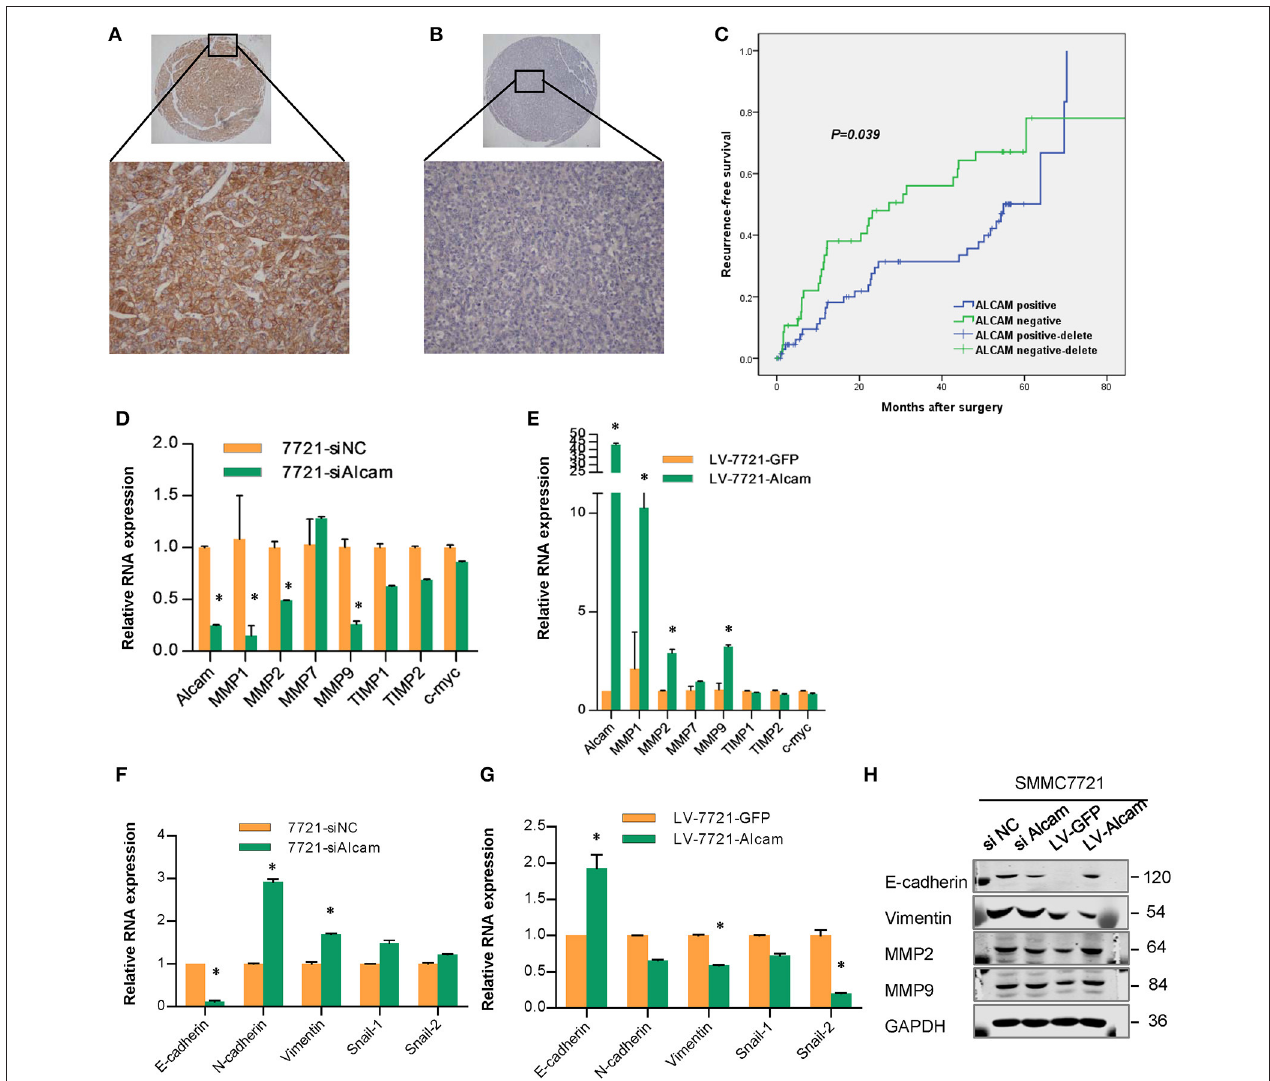
FIGURE 6 | Immunohistochemistry staining and microarray analysis of ALCAM in HCC patients and relationship of ALCAM and EMT related genes. (A) The positive staining of ALCAM was mainly located at the cellular membrane, compared with negative staining in HCC (B) ; (C) Kaplan-Meier analysis of the correlation between ALCAM expression and the recurrence-free of patients with HCC. Log-rank tests were used to determine statistical significance. The expression of ALCAM was associated with the recurrence-free survival of patients with HCC, ALCAM negative cases had worse TTR than positive cases (log-rank test, p < 0.05). (D–G) Relative mRNA levels as measured by qPCR of the EMT related genes in SMMC-7721 cells transfected with si-NC or si-ALCAM (D,F) and infected with control and LV-ALCAM (E,G) . (H) Western blot showed that the expression of ALCAM and the EMT markers in SMMC-7721 cells with ALCAM siRNAs or stably transfected with Lenti-ALCAM. * p <